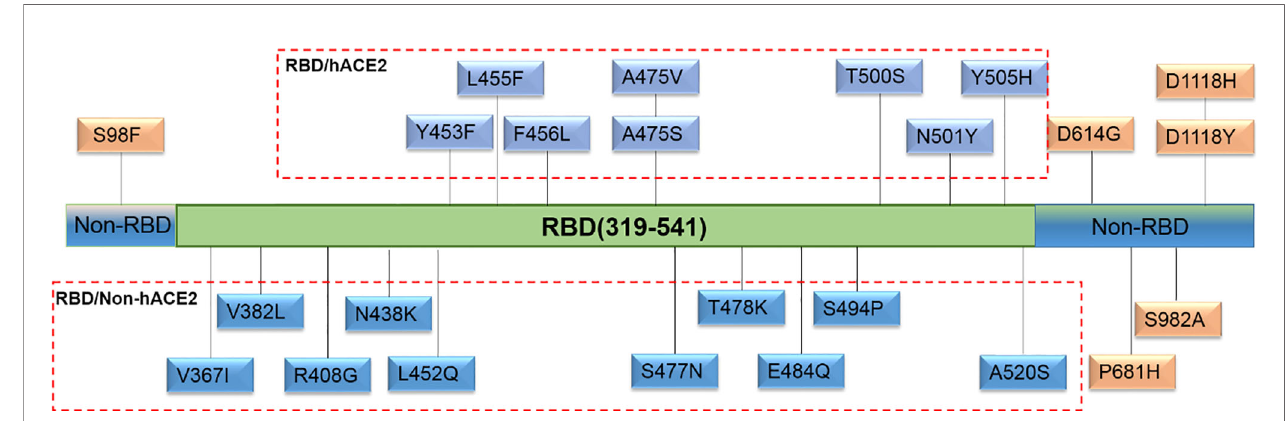
FIGURE 1 | Natural and high-frequency amino acid mutations of the spike protein selected in this study. Twenty-four single amino acid mutations were located in three regions. Eight mutations (Y453F, L455F, F456L, A475V, A475S, T500S, N501Y, and Y505H) were in the RBD and hACE2 interaction region (RBD/hACE2); 10 mutations (V367I, V382L, R408G, N438K, L452Q, S477N, T478K, E484Q, S494P, and A520S) were in the RBD region but no interaction with hACE2 (RBD/Non- hACE2); 6 mutations (S98F, D614G, P681H, S982A, D1118H, and D1118Y) were not in the RBD region